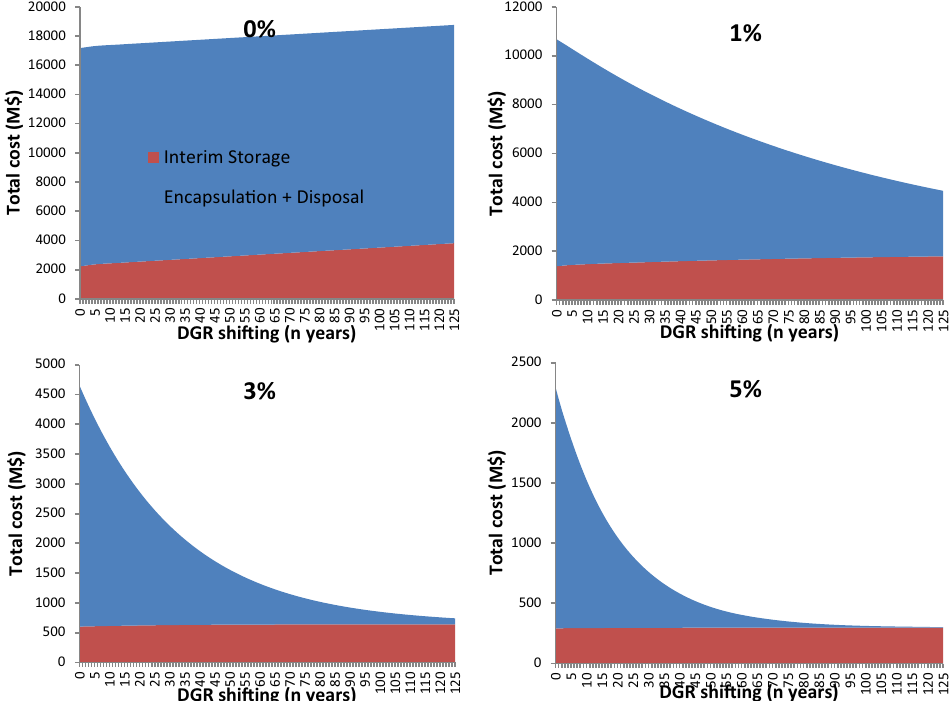
Fig. 8. Effect of rescheduling DGR deployment for n years with different discount